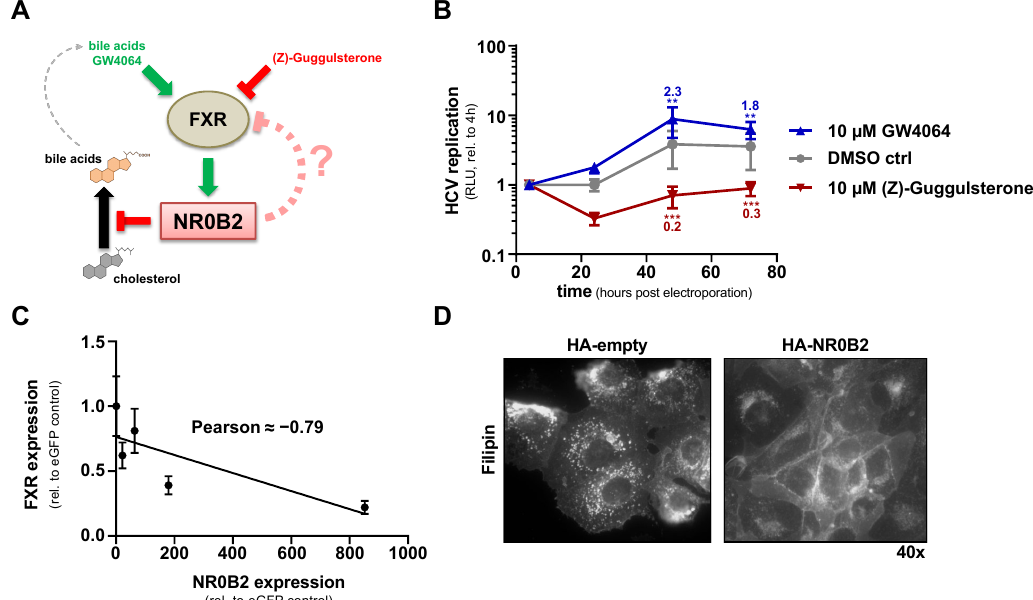
Figure 8. HCV replication strongly depends on an intact cholesterol-bile acid axis, orchestrated by FXR and NR0B2. ( A ) Schematic of the FXR-NR0B2 axis that regulates bile acid synthesis. ( B ) Replication of a subgenomic luciferase reporter replicon (gt1b) after electro-transfection into Huh7-Lunet HA-eGFP cells treated with 10 µ M GW4064, (Z)-Guggulsterone, or DMSO as a control in a time-course of 72 h. ( C ) FXR expression levels in Huh7-Lunet cells with di ff erent overexpression levels of HA-NR0B2. ( D ) Free cholesterol distribution visualized by Filipin-III staining in HA-NR0B2 overexpressing Huh7-Lunet cells. Luciferase data ( B ) is normalized to the input signal four hours post transfection and shows mean and standard deviation from three independent biological experiments. Significance was calculated using two-tailed, non-paired Student’s t -test. ** p ≤ 0.005, *** p ≤